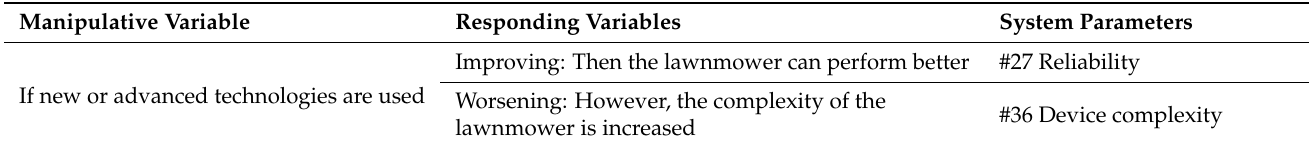
Table 12. Inventive principles from system parameters of technical contradictions (constraint